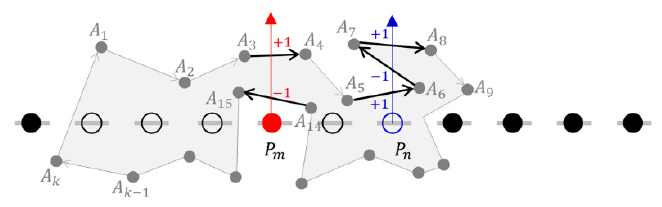
Figure A2. An example of the winding number algorithm.